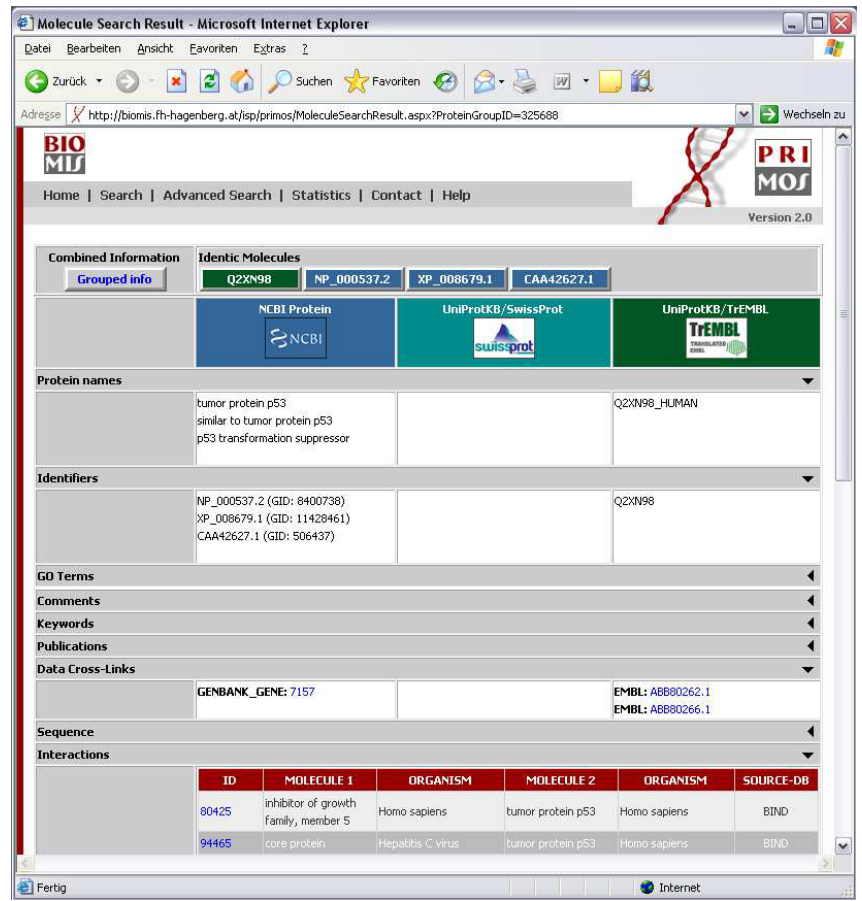
Figure 2: Cumulated display of tumor protein